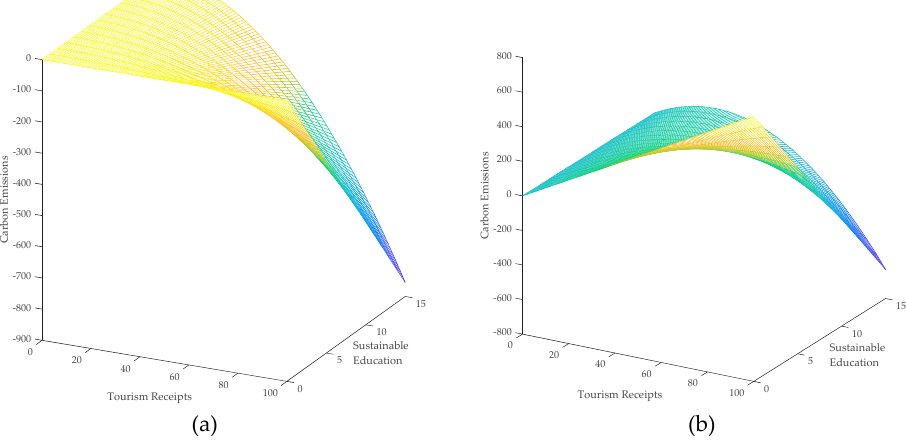
Figure 4. ( a ) Direct and ( b ) indirect effect of tourism on carbon emissions using sustainable education as the moderator.